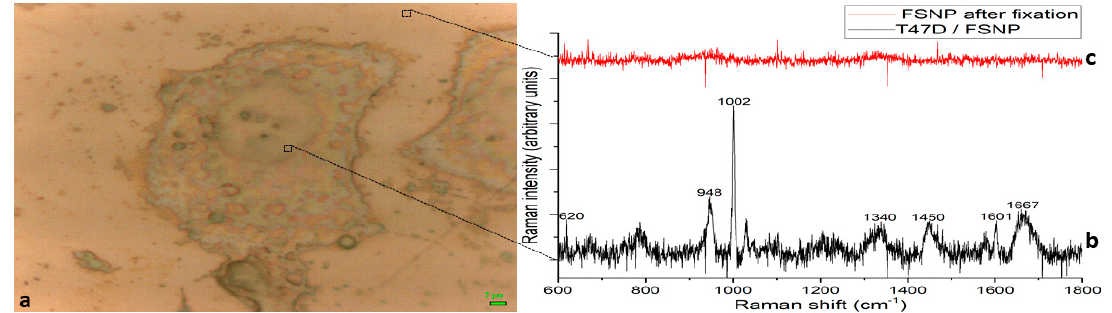
Figure 5. ( a ) Optical image of a T47D cell attached on a FSNP; ( b ) Raman spectrum of the T47D breast cancer cell attached on a FSNP and ( c ) Raman spectrum of the FSNP after cell fixation by an ethanol dehydration train. Scale bar: 2 µm.